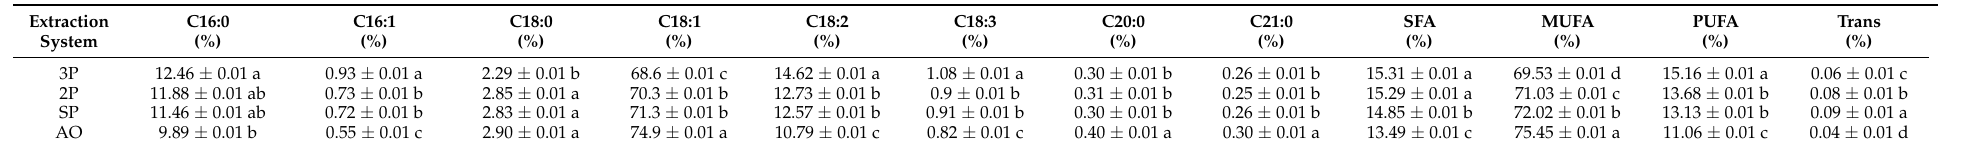
Table 2. Mean values of fatty acids in olive oil (cv ‘Moroccan Picholine’) according to the extraction system. Results are expressed as mean ± SD (n = 9). Within each column, values followed by the same letter are not significantly different at p < 0.05. SFA = saturated fatty acids, MUFA = monosaturated fatty acids, and PUFA = polysaturated fatty acids.